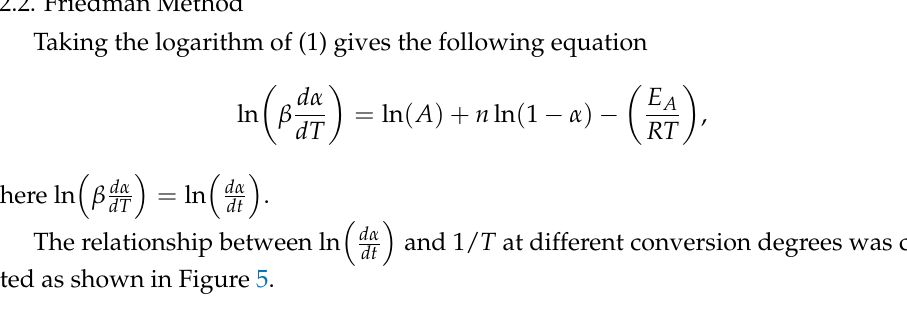
Table 2. Kinetic parameters by Kissinger method. Reactions Step 1 Step